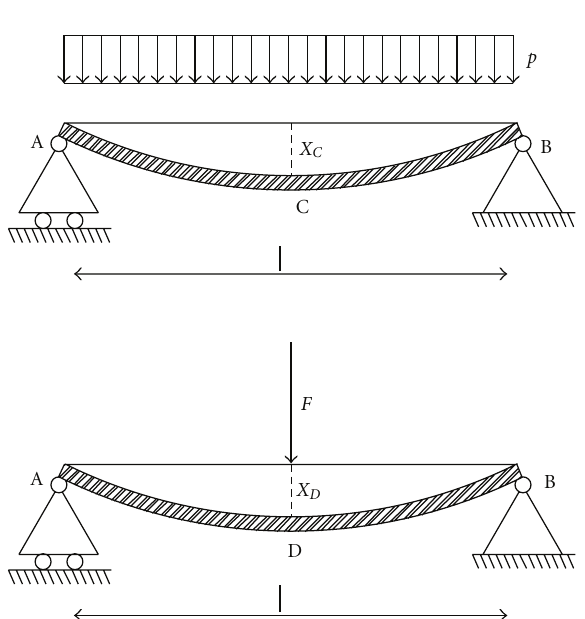
Figure 3: Deflection of a simply supported beam under uniformly distributed and concentrated